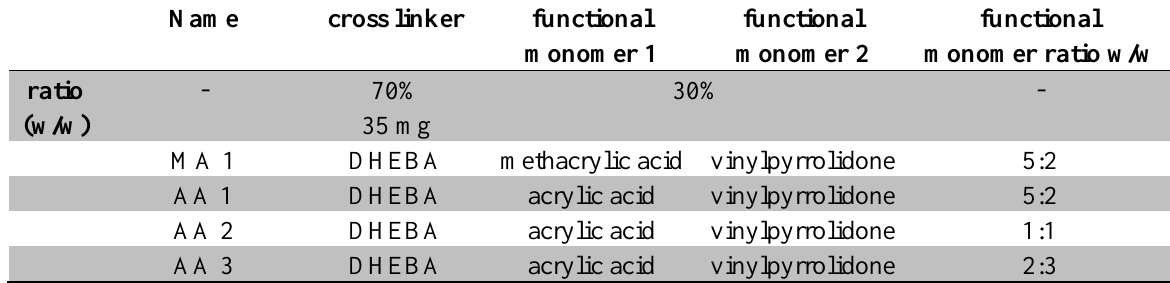
Table 2. Polymer compositions with a constant ratio of cross linker (70%